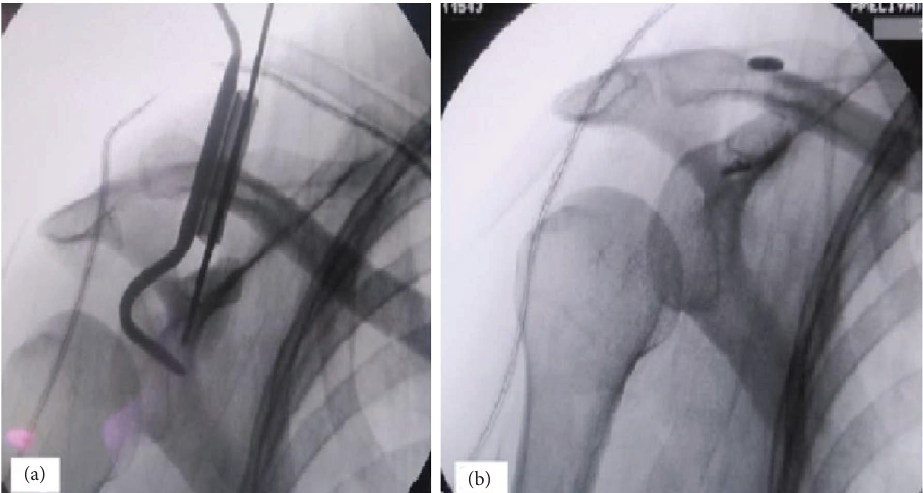
Figure 3: (a)-(b) Depicts the intraoperative procedure